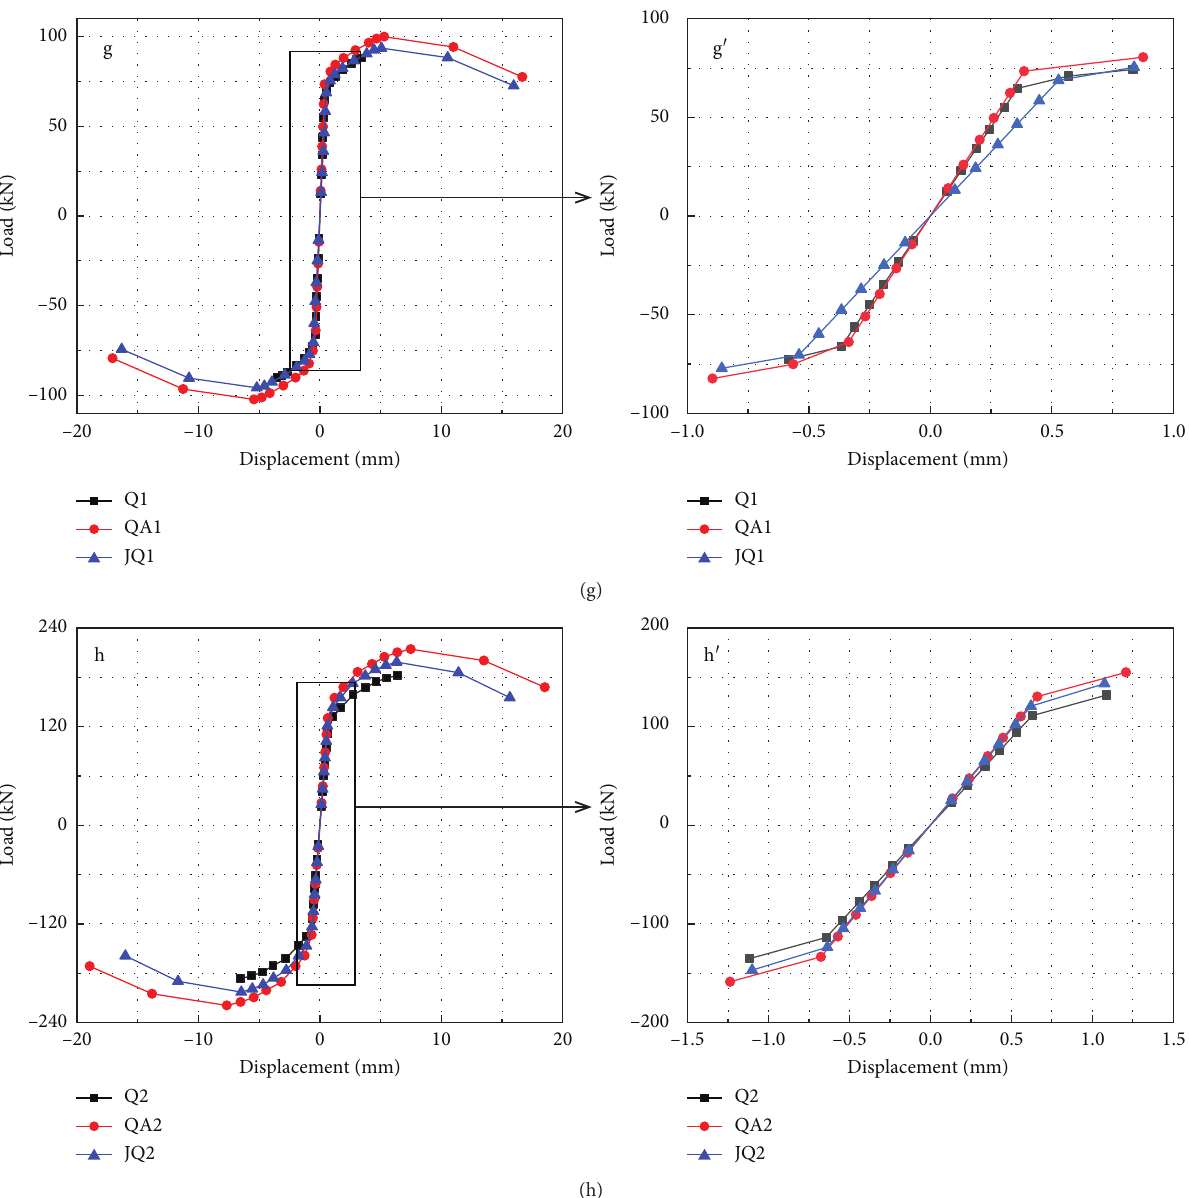
Figure 6: Hysteresis curve and skeleton curve of specimen. (a) Hysteresis curve of specimen Q1. (b) Hysteresis curve of specimen Q2. (c) Hysteresis curve of specimen QA1. (d) Hysteresis curve of specimen JQ1. (e) Hysteresis curve of specimen QA2. (f) Hysteresis curve of specimen JQ2. (g) Skeleton curve of wall with the aspect ratio of 1.8. (g ′ ) Magnification of the skeleton diagrams. (h) Skeleton curve of wall with the aspect ratio of 0.5. (h ′ ) Magnification of the skeleton developing, the load increment became smaller, the hys- corresponding to the ultimate load scarcely change com- teresis loop area increased gradually, the residual defor- pared with that of specimen Q2. mation started to increase, and the specimen stiffness began to degenerate. Finally, the hysteresis loop shifted to a hor- izontal axis, indicating the specimen stiffness decreased rapidly. curve and the skeleton curve of each specimen are shown in For reinforced specimens QA1, QA2, JQ1, and JQ2, the Figure 6. It can be observed that: for specimen Q1 and Q2, hysteresis curves were similar to those of unreinforced the deformation was small during the initial loading stage, specimens Q1 and Q2 during the initial loading process. and the area encompassed by the hysteresis loop was also After cracks occurred, the hysteresis loop of the reinforced small. After cracking, specimen Q1 failed very soon, and the specimens became plumper and encompassed a larger area. hysteresis loop terminated. For specimen Q2, with the cracks